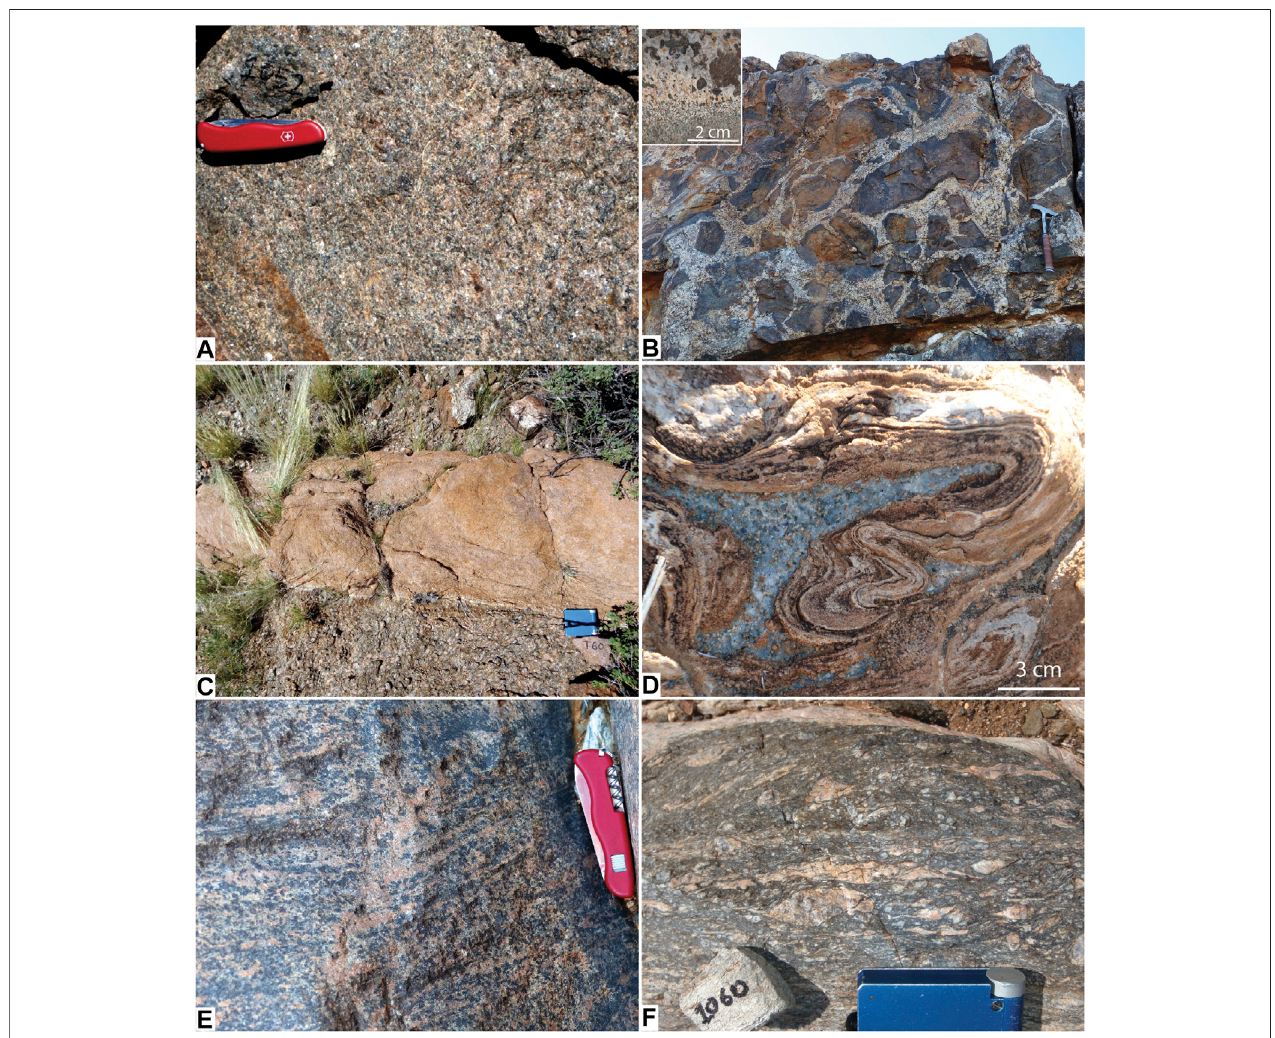
FIGURE 3 | Field appearance of the Swartoup and Polisiehoek plutons and their host rocks. (A) Alkali feldspar-rich Swartoup leucogranite from the interior of the pluton with undeformed magmatic texture. (B) Magmatic megabreccia in ma fi c granulites of the Bysteek Formation. The intruding facies of the Swartoup Pluton is leucocratic and may be alkali feldspar or plagioclasedominated, but always shows large magmatic clinopyroxene. This type of granitoid is restricted to the contact zone of the Swartoup pluton with the metabasites of the Bysteek Formation. Inset: Centimeter-sized magmatic clinopyroxene in leucocratic matrix at the contact to a fi ne-grainedmetabasitefragment.Gradationalcontactsindicatetheinteractionoftheintrudingmagmawiththebrecciaclasts. (C) DykeofPolisiehoekGranitecuttingthe Swartoup Pluton at sharp intrusive boundaries. Elswhere, such contacts are commonly sheared. (D) Convoluted folding of marble and calc-silicate rock layers of the Bysteek Formation. (E) Stromatic to nebulitic migmatite of the Koenap Formation with abundant garnet in alkali feldspar-rich leucosome. Cordierite and sillimanite, or biotitearecommonlypresent. (F) AlkalifeldsparphenocrysticSwartoupPlutonoverprintedduringregionaldeformationathightemperaturealongashearzoneparallelto the Hartebees River shear zone (Loc. 1,060; Figure 1B